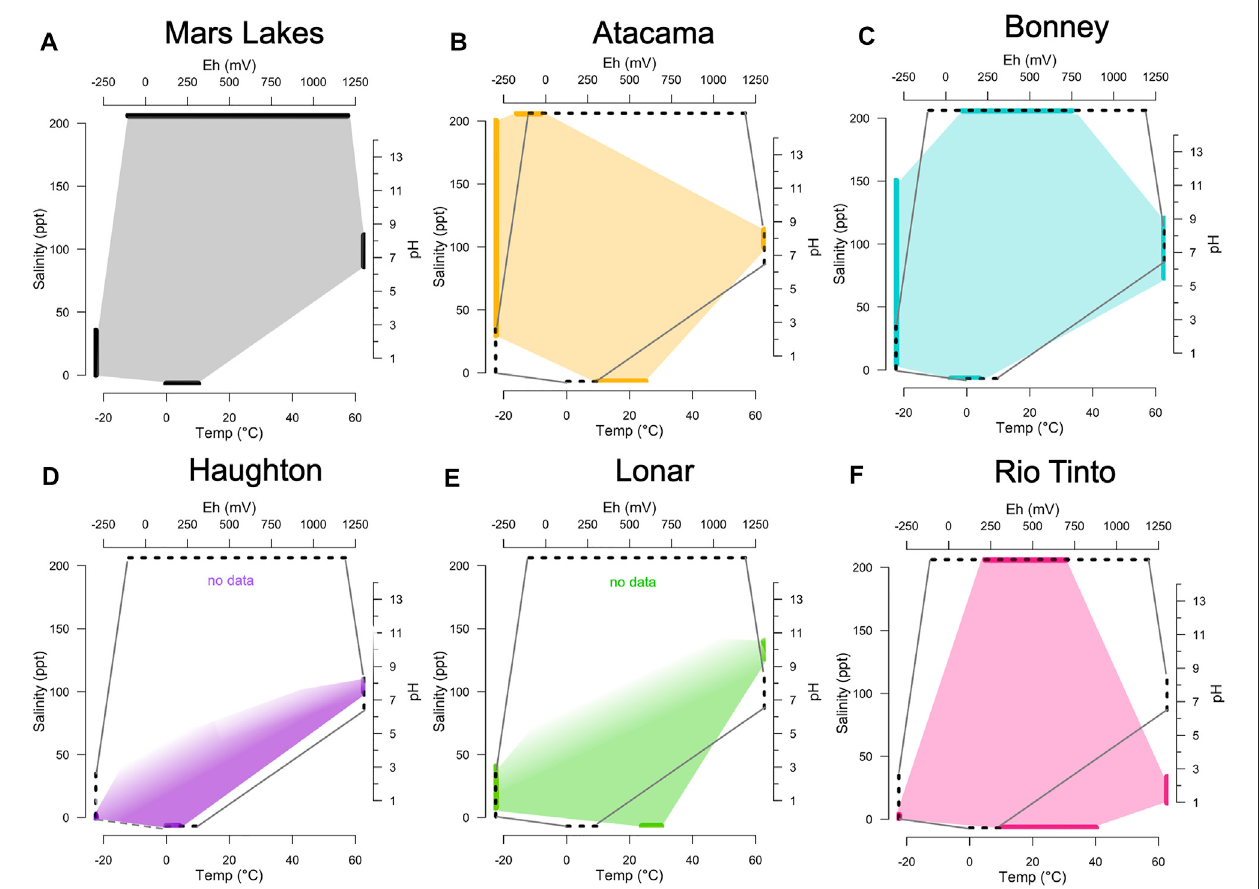
FIGURE 5 | (A) The temperature, salinity, pH and redox potential ( E h ) boundaries predicted for Mars lakes during the Late Noachian to Early Hesperian. Martian lakes compared to (B – F) boundaries observed for fi ve terrestrial Mars analog sites discussed in the main text. Each polygon edge (thick lines) represents the range observed for a single parameter. Filled polygon areas represent parameter distributions in multidimensional space. The dashed polygons in (B – F) compare the martian lakesparameter distribution to each terrestrial analog. Missing values are indicated by the absence of apolygon edge on a particular axis. Note that the Mars lakes polygon (A) depicts best estimates of parameter ranges when liquid water was present. All of the terrestrial analog polygons (B – F) depict boundaries for liquid water present in the modern environment. Modeled after Merino et al.,